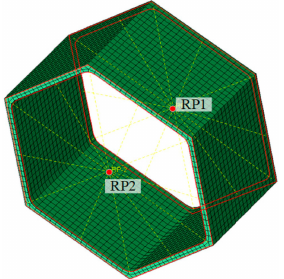
Figure 11. Numerical model of honeycomb